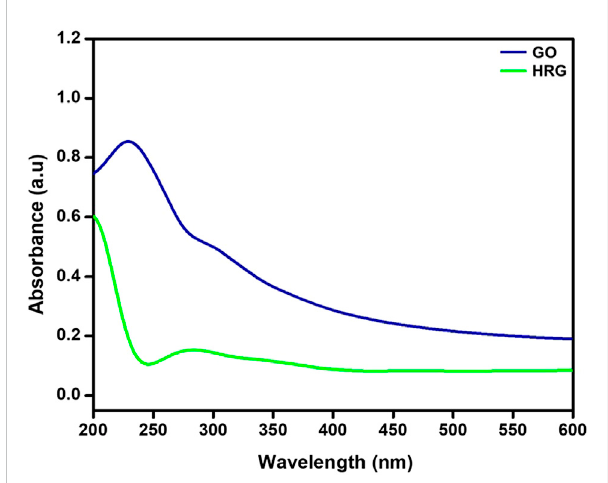
FIGURE 1 UV-Vis absorption spectra of Graphite oxide (GO) and highly reduced graphene oxide (HRG).